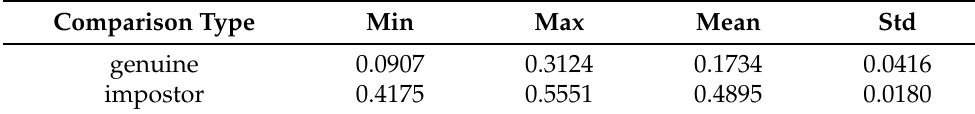
Table 3. Matching distance statistics for the dataset in Figure